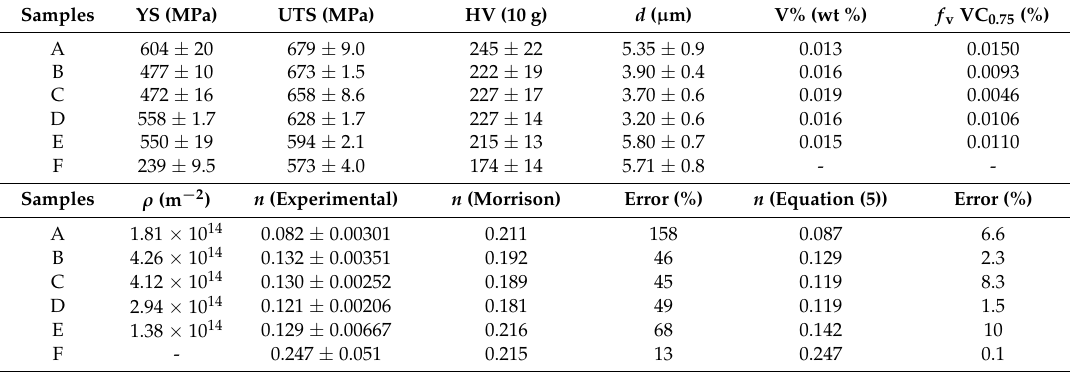
Table 4. Tensile mechanical properties (YS and UTS), average microhardness (HV), average grain size ( d ), amount of vanadium in ferritic solid solution (V%), volume fraction ( f v ) of VC 0.75 , dislocation density ( ρ ), strain-hardening exponent ( n ) from the experimental data, the Morrison model and the modified model (Equation (5)) for the API X80 steel submitted to different processing conditions.